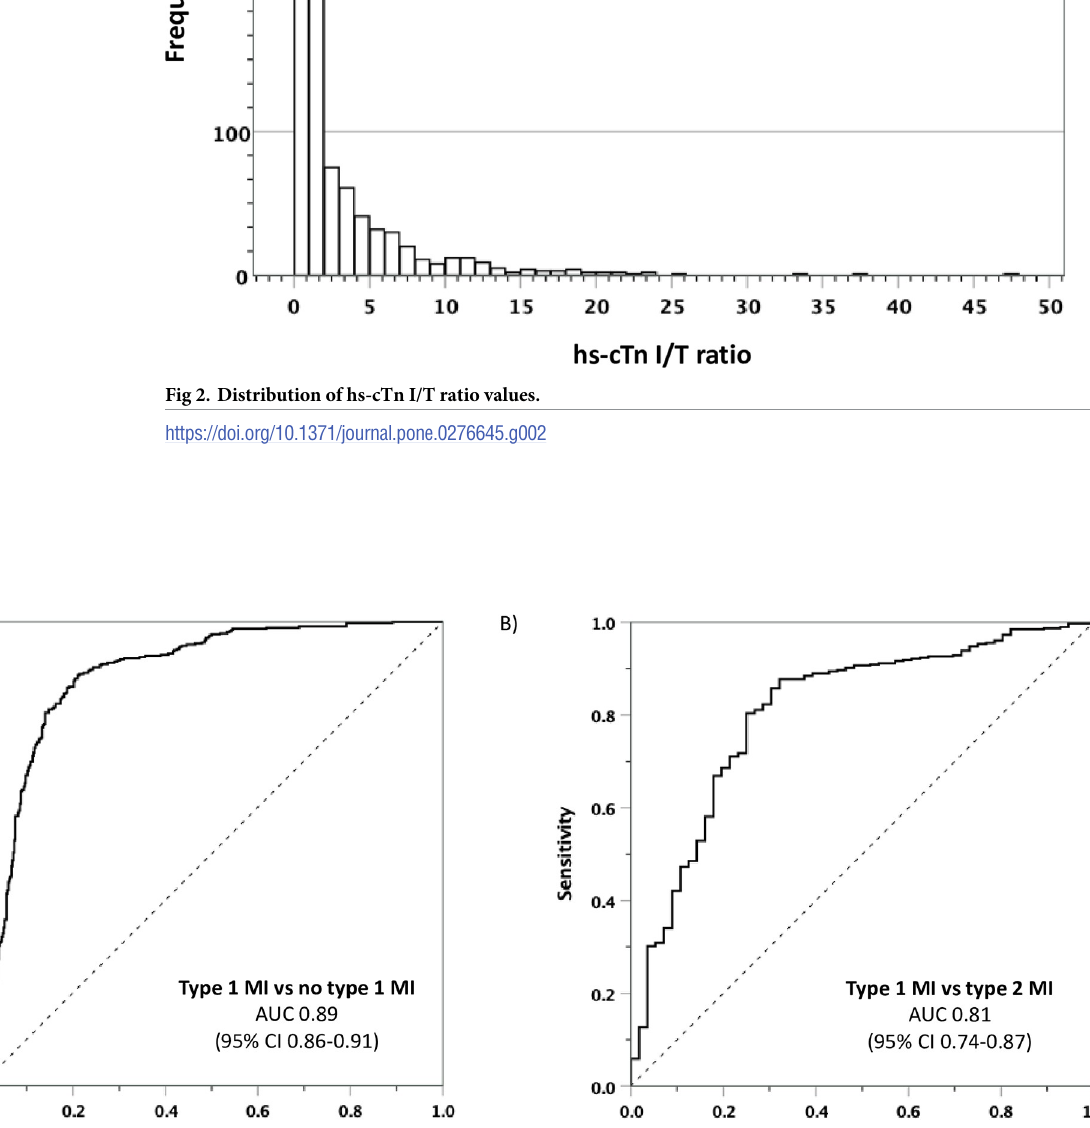
PLOS ONE | https://doi.org/10.1371/journal.pone.0276645 November1,